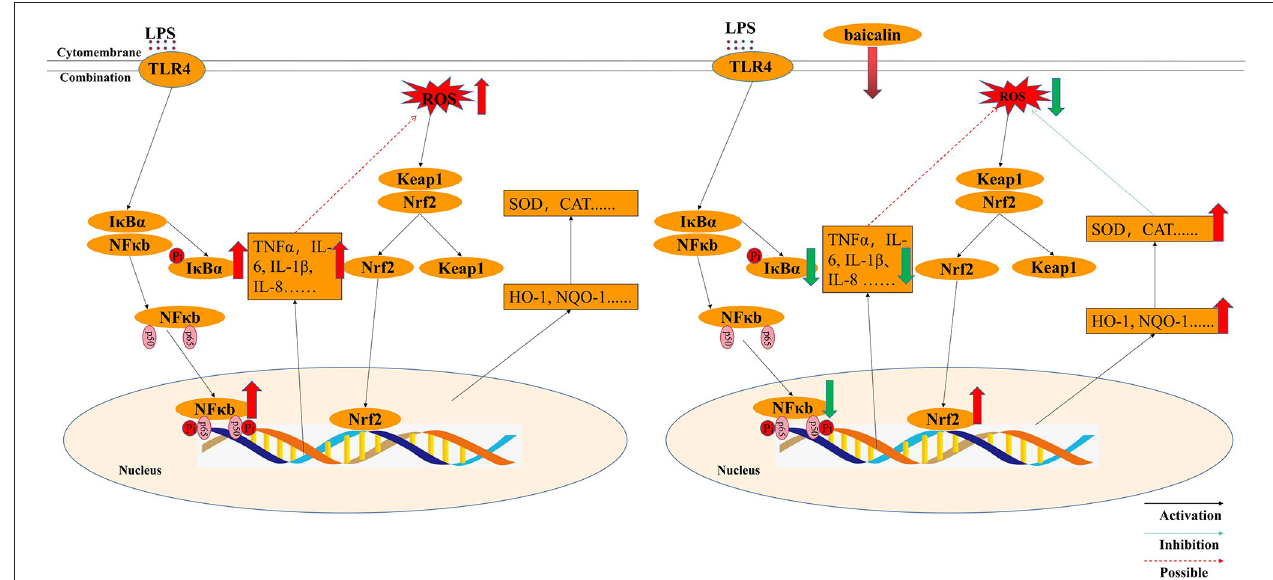
FIGURE 8 | Molecular mechanism by which baicalin alleviated LPS-induced inflammatory responses and oxidative stress model in IPEC-J2 cells.